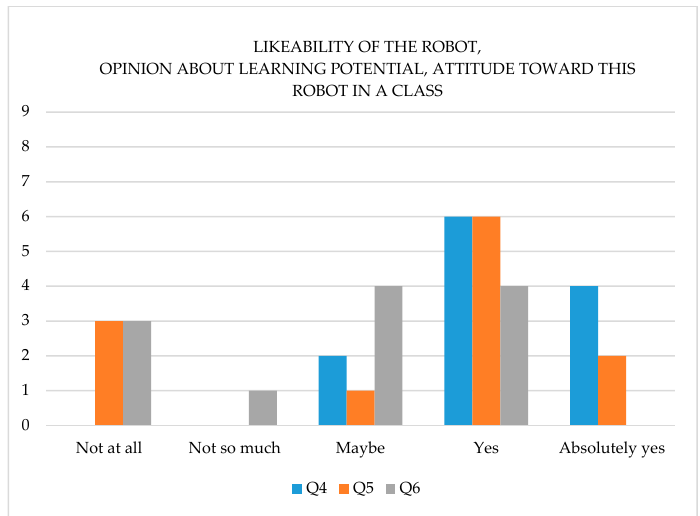
Figure 4. The figure shows the results of the second set of questions submitted to parents. The list of numbers on the left axis of the graphs indicates the number of parents.